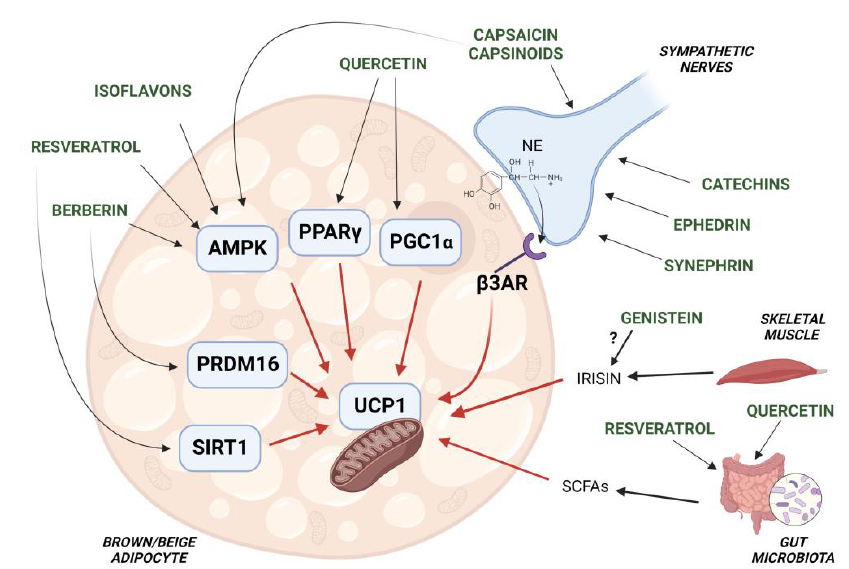
Figure 2. Schematic representation of the molecur targets involved in brown/beige adipocyte thermogenesis, which are regulated by nutraceuticals. UCP1 function of brown/beige adipocytes is activated by capsinoids, catechins, ephedrine and synephrin via stimulation of the sympathetic nervous system (SNS). Other phytochemicals such as quercetin, resveratrol, isoflavones and berberin directly promote the activation of factors (i.e., PPARγ, AMPK, PRDM16) which increase UCP1 function and expression. Adipocyte AMPK is also activated by capsinoids. Both resveratrol and quercetin have been shown to affect gut microbiota function, resulting in increased production of SCFAs which stimulate UCP1-dependent thermogenesis. Of note, the isoflavone genistein has been shown to increase the circulating levels of the myokine irisin which, in the adipose tissue, induces expression of thermogenic genes, including UCP1.